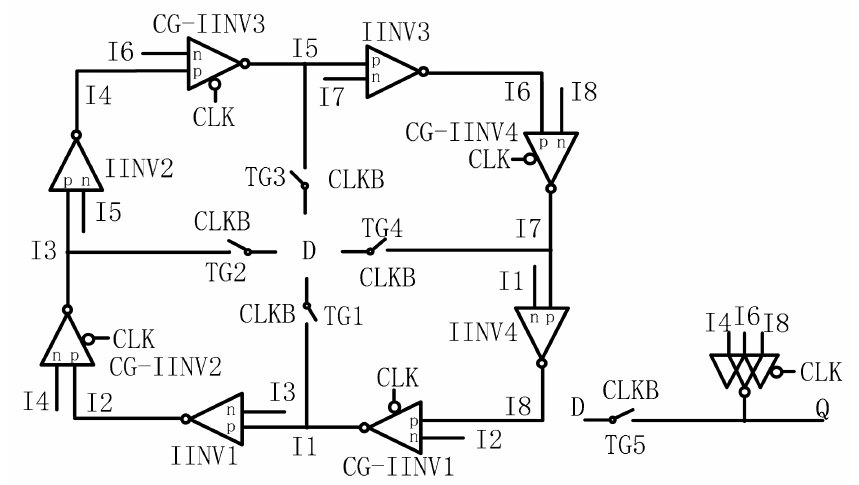
Figure 7. LCDNUT